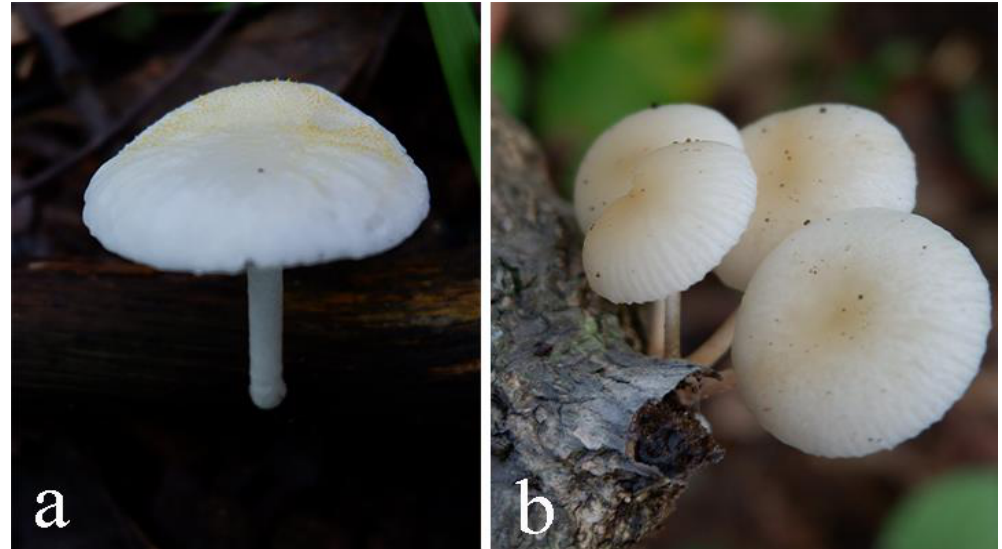
Figure 1. Basidiomata of Oudemansiella collected from the wild in Thailand. ( a , b ). Oudemansiella spp. (HT19-0047, HT19-0050). Photos by A.G. Niego.